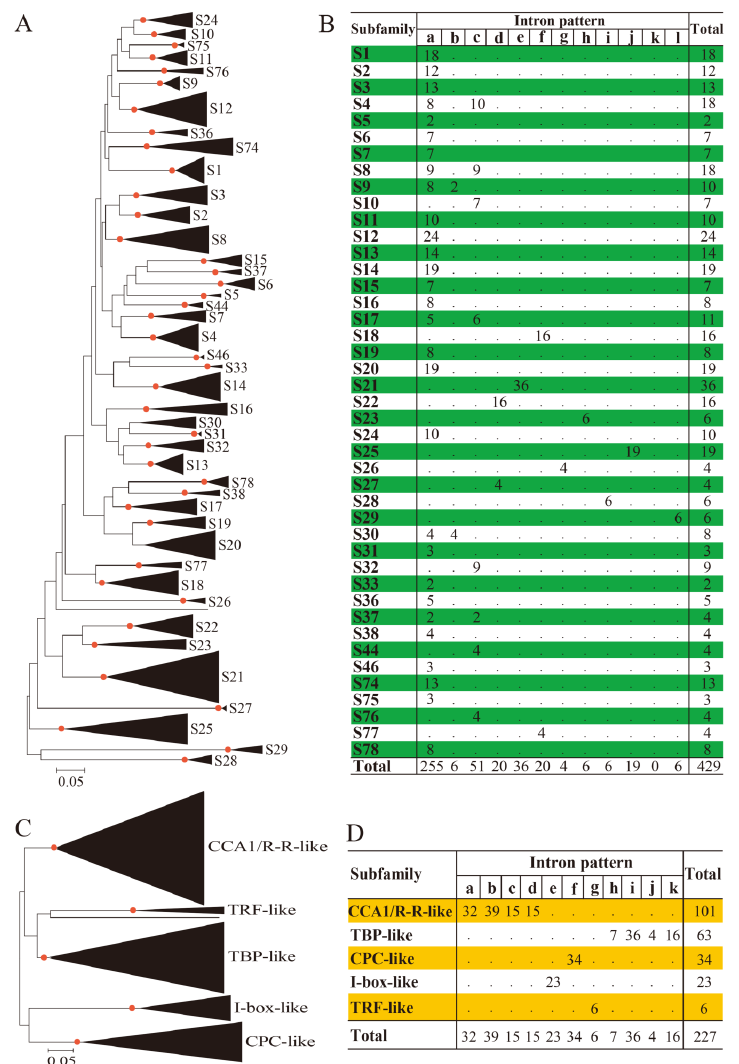
Figure 1. Phylogenetic relationships and intron patterns of MYBR and 2R-MYB proteins from Brassica napus (Bn) and Arabidopsis thaliana (At). The unrooted phylogenetic trees were constructed using the neighbor-joining (NJ) method based on the alignment of the MYB domains of the 429 B. napus 2R-MYBs and 127 A. thaliana 2R-MYBs (including the CDC5 like proteins), and the MYB-like domains of the 227 B. napus and 68 A. thaliana MYBR proteins, respectively. Nodes with bootstrap values ≥ 70% are dotted in red. The scale shows the relative di ff erences in the examined sequences. Subfamilies are represented in compressed subtree by black triangles with both depth and width proportional to sequence divergence and size, respectively. ( A ) The NJ tree of 556 2R-MYB proteins from B. napus (429 proteins) and A. thaliana (127 proteins), which were divided into 43 subfamilies (S1–S33, S36–S38, S44, S46, and S74-S78). ( B ) Summary of intron patterns identified for the 43 B. napus 2R-MYB subfamilies. Intron patterns ‘d–h’ and ‘l’ were designated by referring to Du et al. 2015 [5]. ( C ) The NJ tree of 295 MYBR proteins from B. napus (227 proteins) and A. thaliana (68 proteins), which were clustered into five subfamilies, namely CCA1 / R-R-like, TBP-like, CPC-like, I-box-like and TRF-like. ( D ) Summary of intron patterns identified for the five B. napus MYBR subfamilies. Intron pattern designation (‘a–k’) was referred to Du et al. 2013